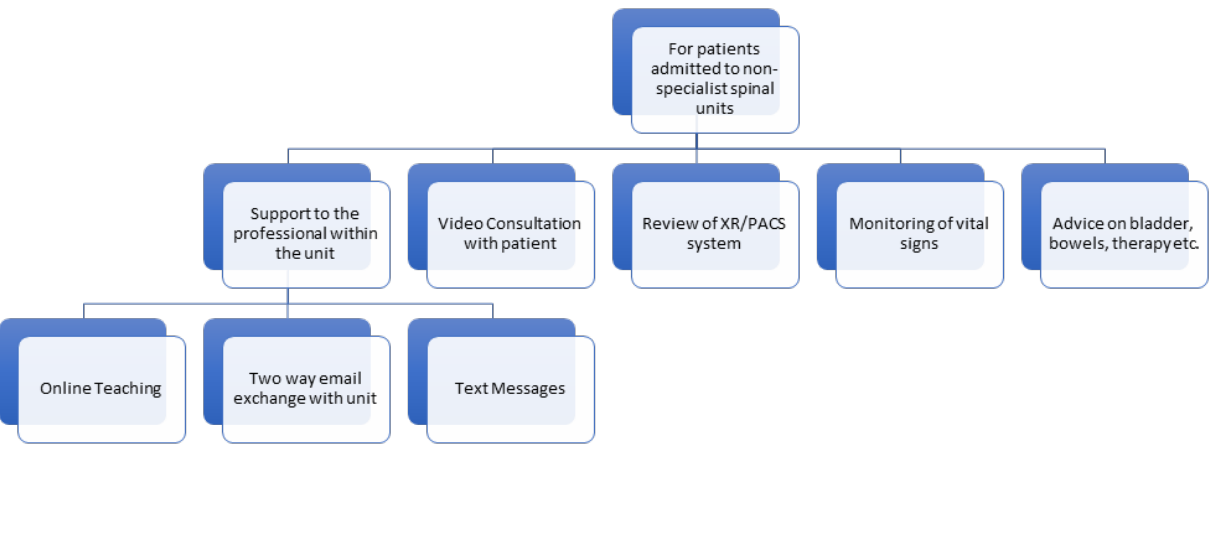
Figure 3. Use of technology in Acute Rehabilitation non-specialist spinal